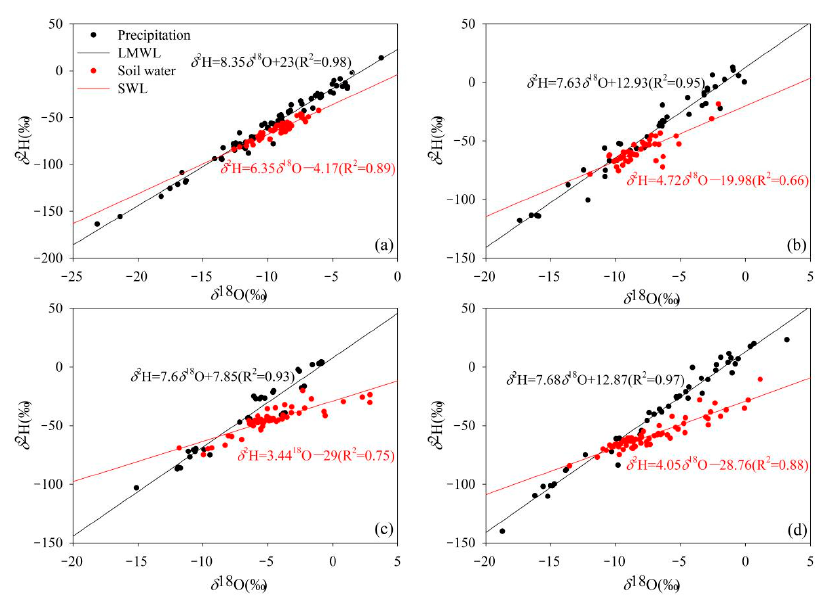
Figure 2. Relationship between soil water δ 2 H and δ 18 O at each sampling point (( a ) Lenglong; ( b ) Ningchan; ( c ) Huajian; ( d ) Xiying).